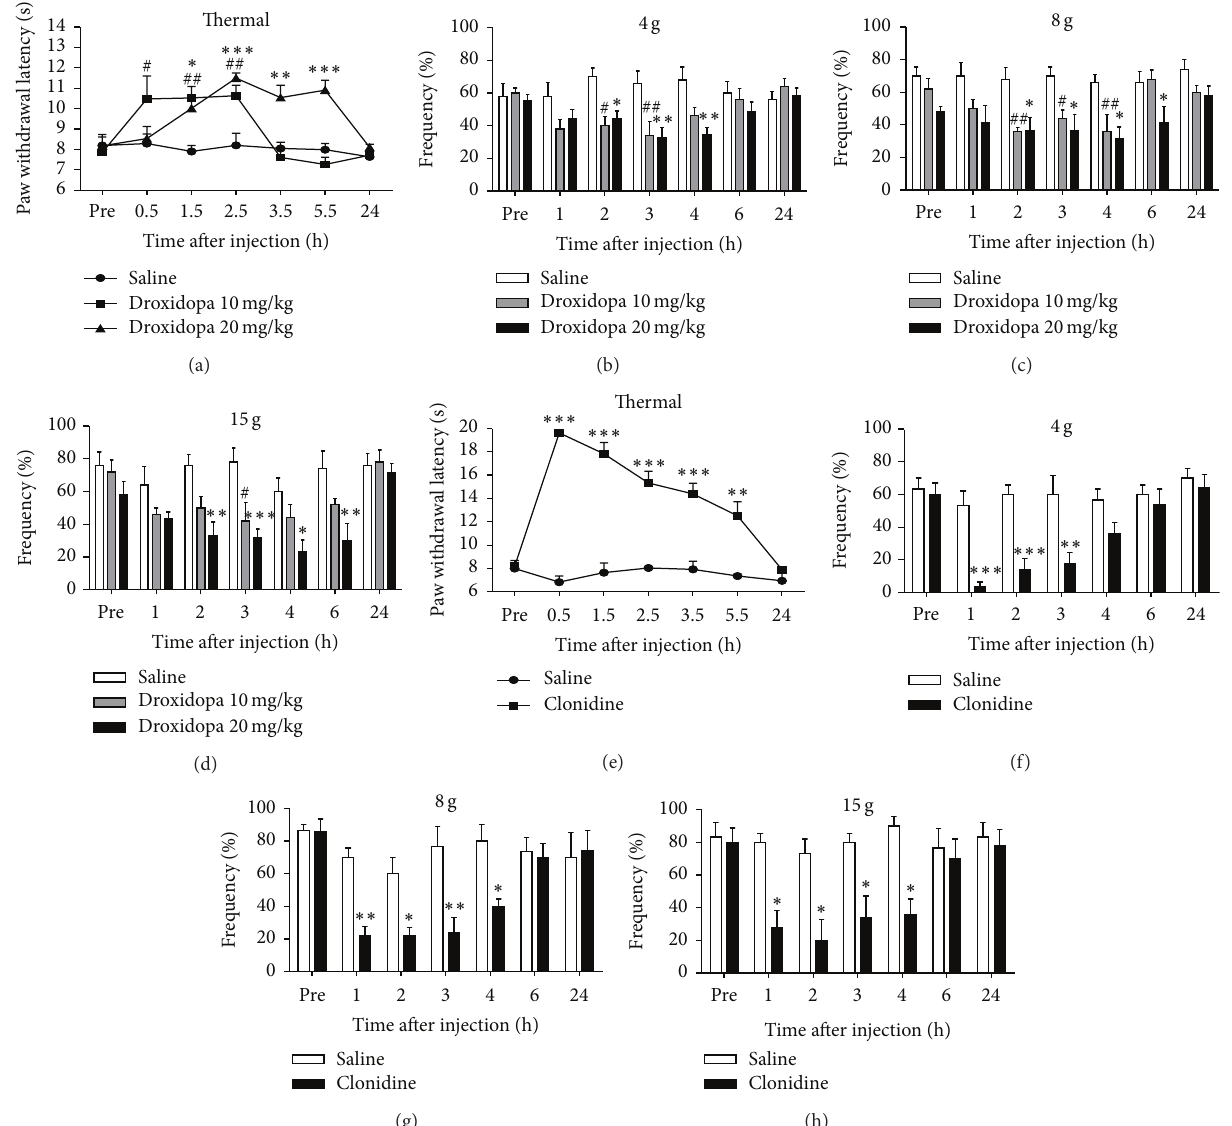
Figure 6: Effects of droxidopa and clonidine on thermal and mechanical hypersensitivity in 6-OHDA-lesioned rats. Rats were i.p. injected with 10mg/kg droxidopa and 20 mg/kg droxidopa or equal volume of saline on the 5th week after surgery. ((a)–(d)) Systemic application of droxidopa significantly inhibited thermal (a) and mechanical hypersensitivity ((b)–(d)) in 6-OHDA-lesioned rats ( ∗ 𝑃 < 0.05 , ∗∗ 𝑃 < 0.01 , and ∗∗∗ 𝑃 < 0.001 for 10mg/kg droxidopa and # 𝑃 < 0.05 and ## 𝑃 < 0.01 for 20 mg/kg droxidopa compared to the saline control, 𝑛 = 5-6